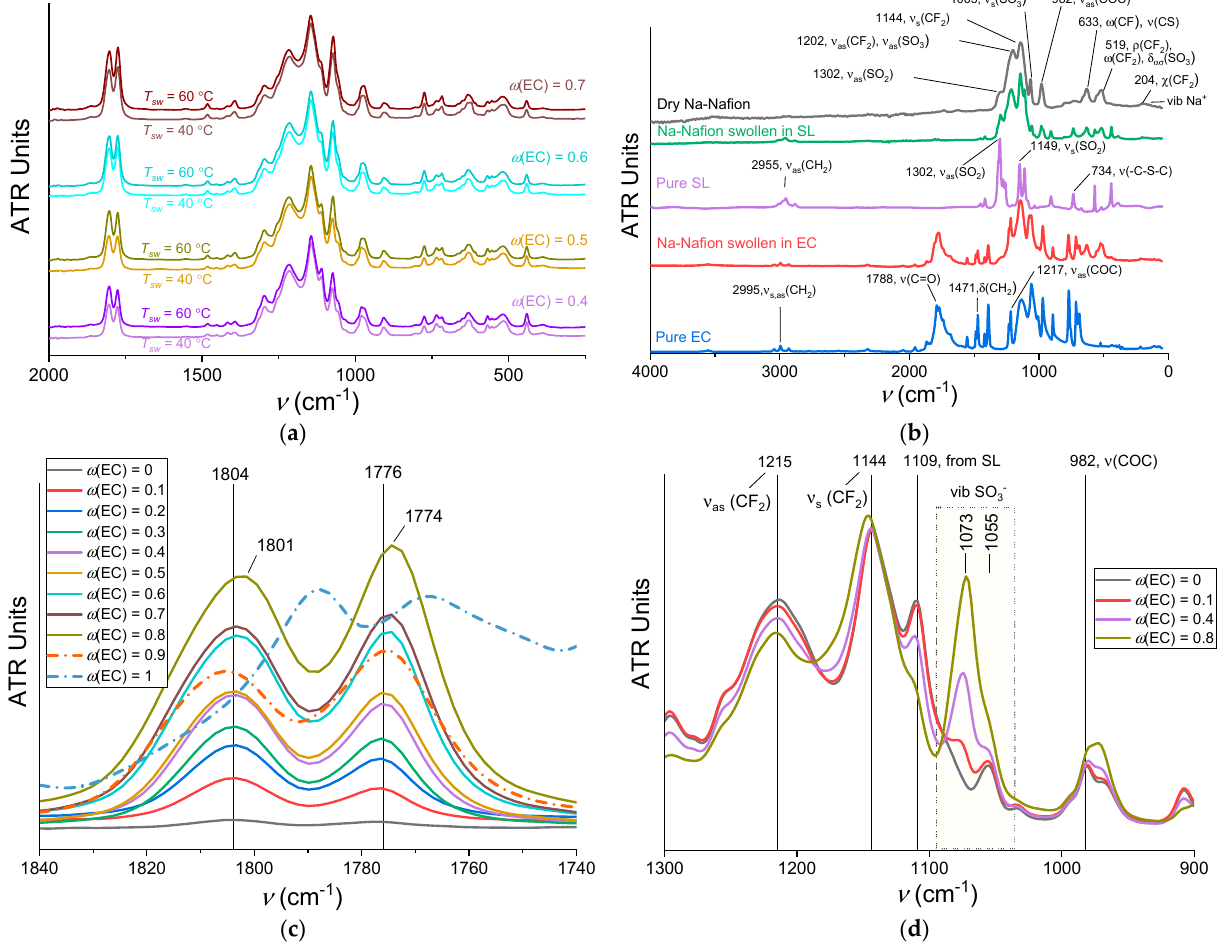
Figure 9. ( a ) The survey FTIR ATR spectra of Na-Nafion membranes swollen at 40 and 60 °C. ( b ) The survey FTIR ATR spectra of Nafion membrane dried over P 2 O 5 , initial solvents EC and SL and swollen Na-Nafion membranes. ( c ) Contours of the analytical band ν (C=O) of EC in the FTIR ATR spectra of swollen Na-Nafion. ( d ) Contours of the analytical band ν (SO) of the Na-Nafion (shaded area) in the FTIR ATR spectra of plasticized